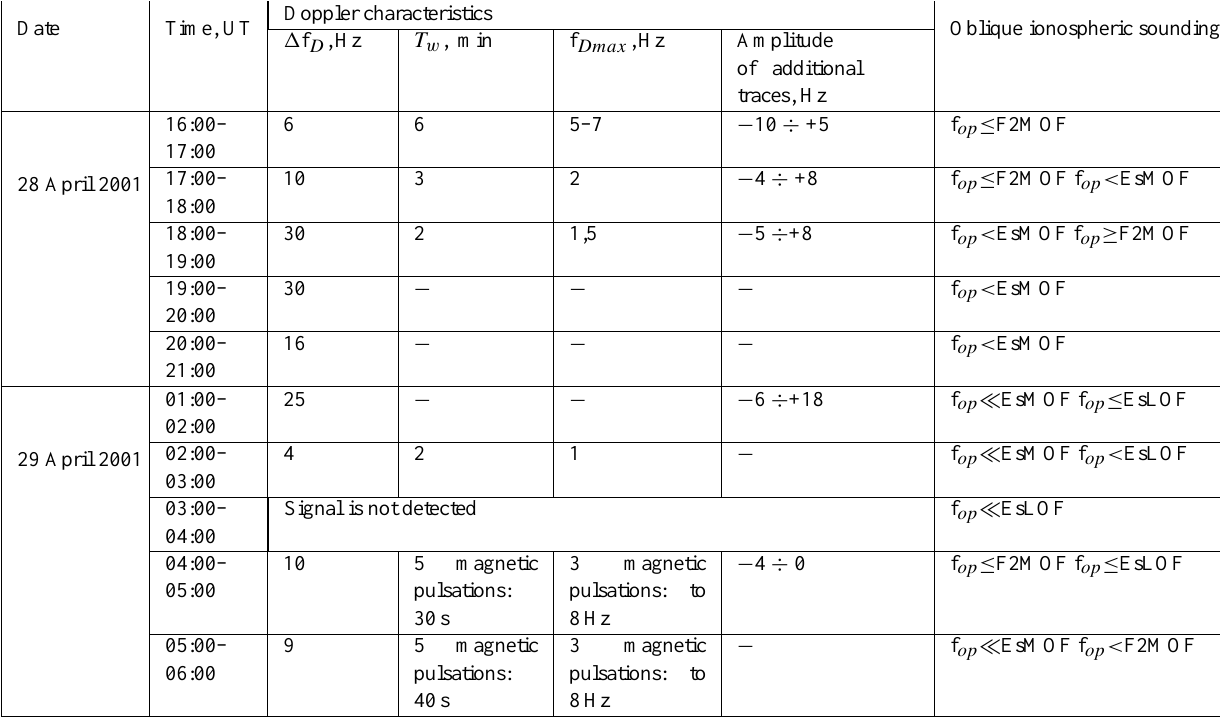
Table 1. Doppler characteristics and OIS data on the path Murmansk-St.Petersburg. f op is the frequency of the Doppler signal (5930kHz).